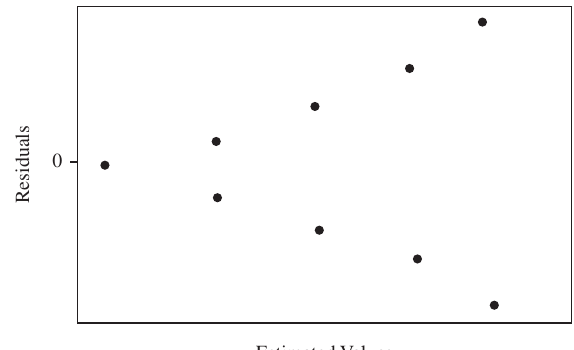
Figure 2. Example of a graph of residuals ( ^ e ( ^ Y ) showing that the variance is i